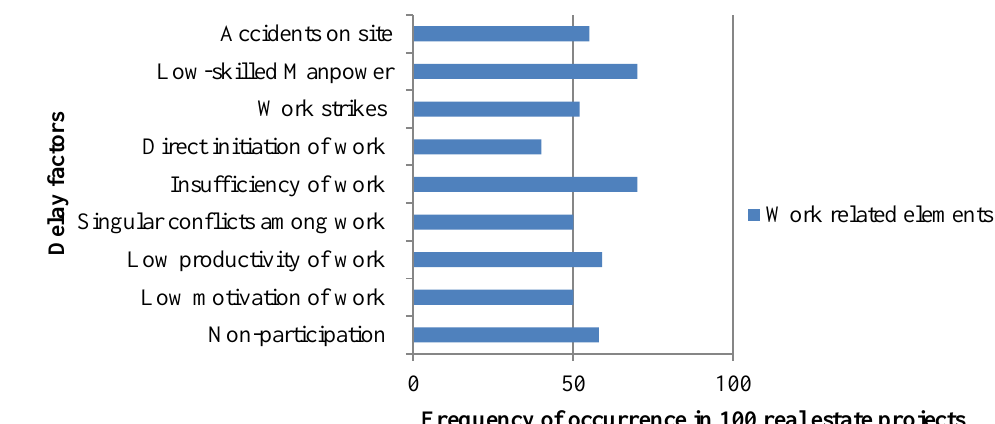
Fig. 6. Frequency of equipment-related delay factors [figure made by authors].